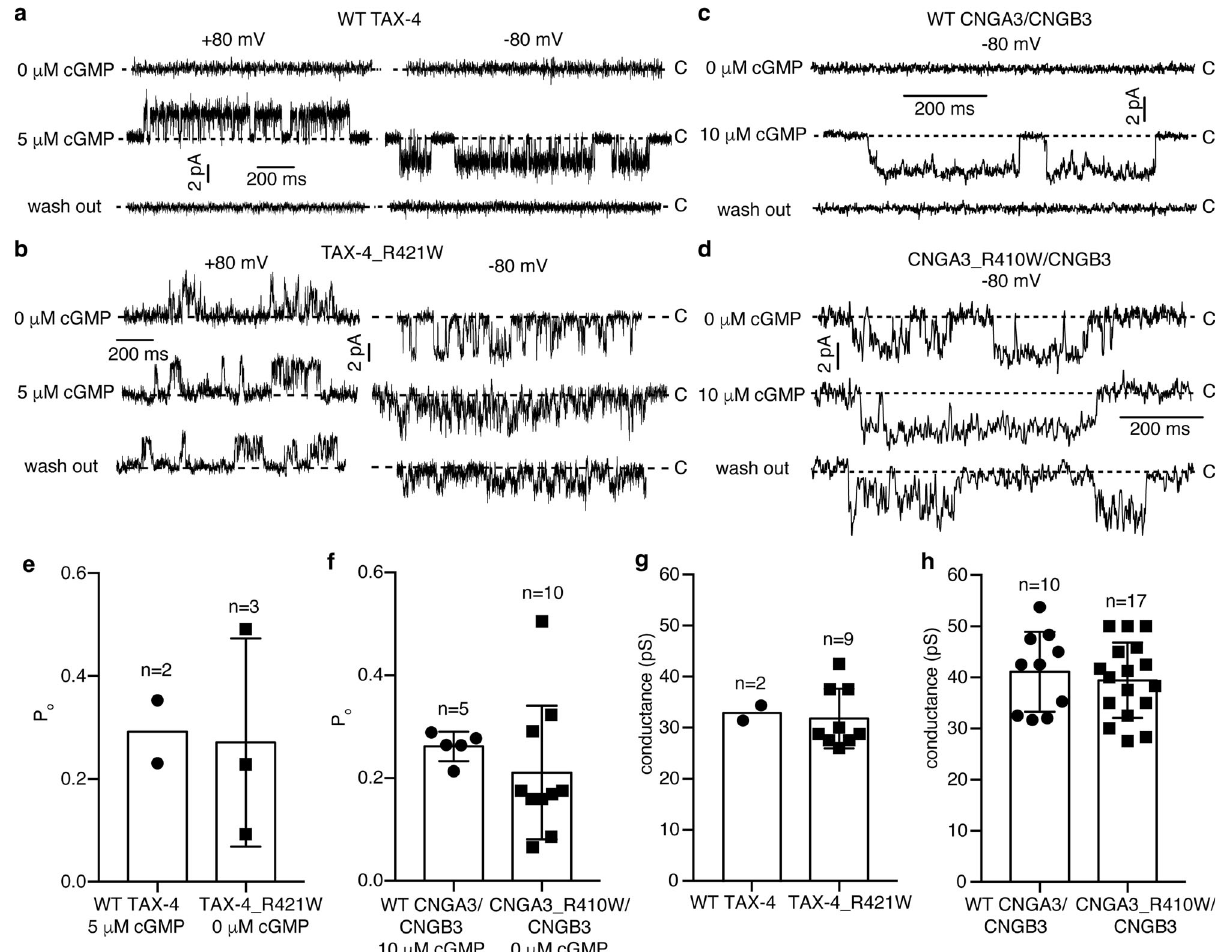
Fig. 4 Single-channel recording of puri fi ed channels. a – d Single-channel currents of the indicate channels reconstituted in liposomes. Currents were recorded at the indicated membrane potentials in the absence or presence of 5 μ M or 10 μ M cGMP in the bath. Dashed lines mark the closed baseline. e – h Single-channel open probability (P o ) ( e , f ) and conductance ( g , h ) of the indicated channels. Each point represents a different patch. Currents of WT TAX-4 and CNGA3/CNGB3 channels were evoked by 5 μ M or 10 μ M cGMP, and currents of the mutant channels were spontaneous openings in the absence of cGMP. Data are presented as mean ± SD. n number of patches. Patches with high noise levels were not included in the P o